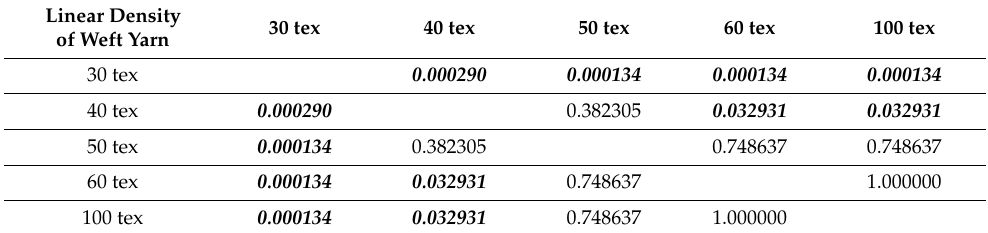
Table 10. The results of the Tukey’s test for the MWRB.